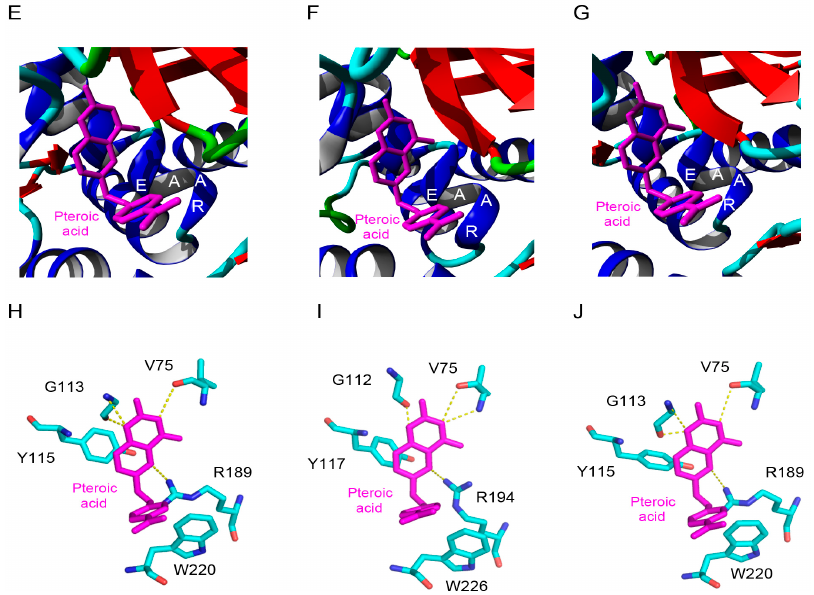
Figure 3. Ribbon diagrams built for the type 1 RIPs from apple ( A ), peach ( B ), and pear ( C ). α -helices, β -sheets and loops/turns, are colored red, blue, and cyan, respectively. ( D ) Superposition of the type 1 RIP models of apple (colored red), peach (colored green), and pear (colored yellow). Docking of pteroic acid (magenta stick) into the active site of type 1 RIPs of apple ( E ), peach ( F ), and pear ( G ), showing the EAAR sequence of the active site. Network of H-bonds (dashed yellow lines) anchoring pteroic acid to the active site in type 1 RIP of apple ( H ), peach ( I ), and pear ( J ). A stacking interaction occurs between pteroic acid and Tyr and Trp residues located in the vicinity of the active site.